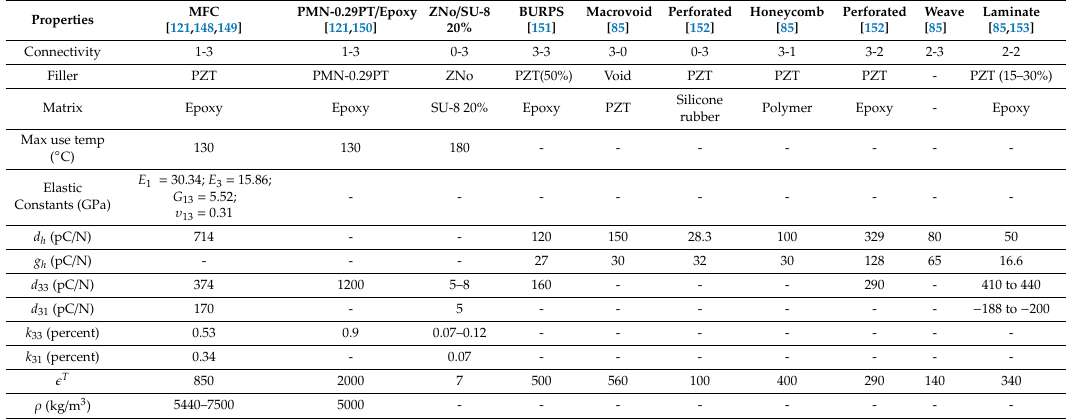
Table 3. Properties of piezocomposites with di ff erent types of piezoelectric fillers such as fibers and particles. MFC: macro fiber composite.